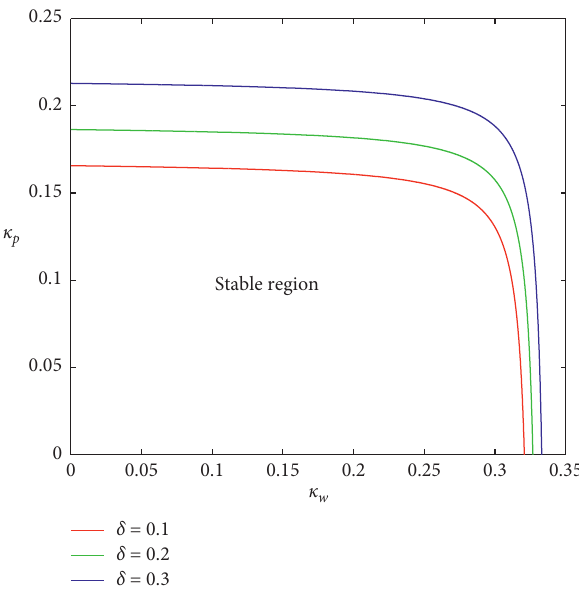
Figure 2: 2D stable region for κ